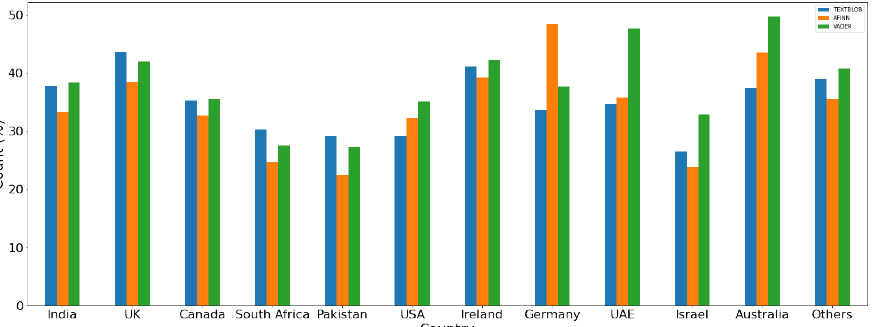
Figure 14. Positive sentiment (%) using each lexicon-based approach.